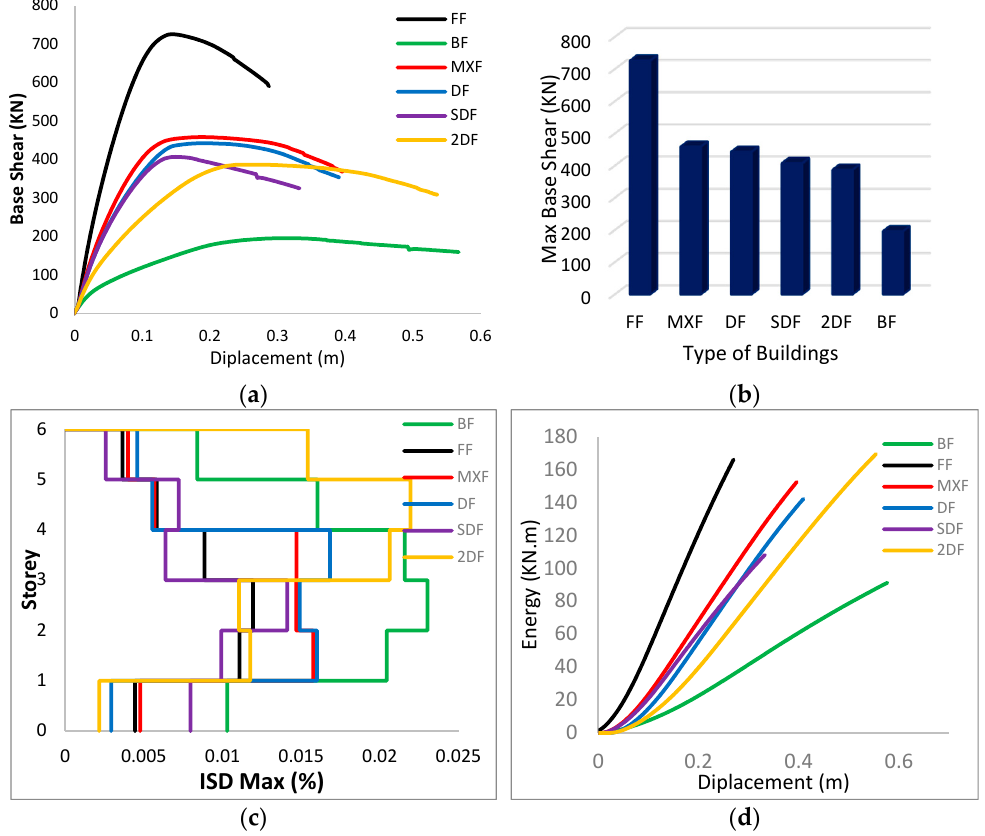
Figure 11. Case N°:4 ( a ) the capacity curve, ( b ) the maxillary base shear values, ( c ) the maximum ISD, ( d ) the energy absorbed curve of the building.